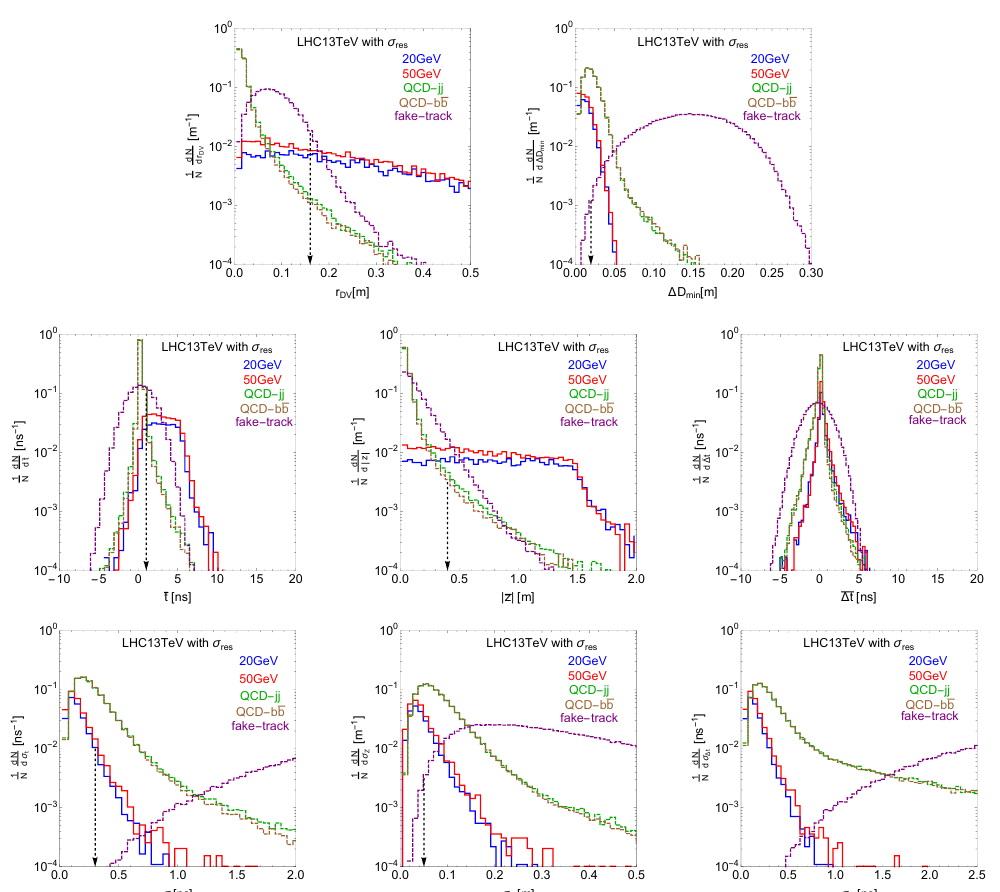
Figure 11 . (VBF channel) The kinetic variable distributions for the QCD background, fake-track background and the signal with angular resolution effect included. The parameter setup is the same as the ggF channel in figure 5.